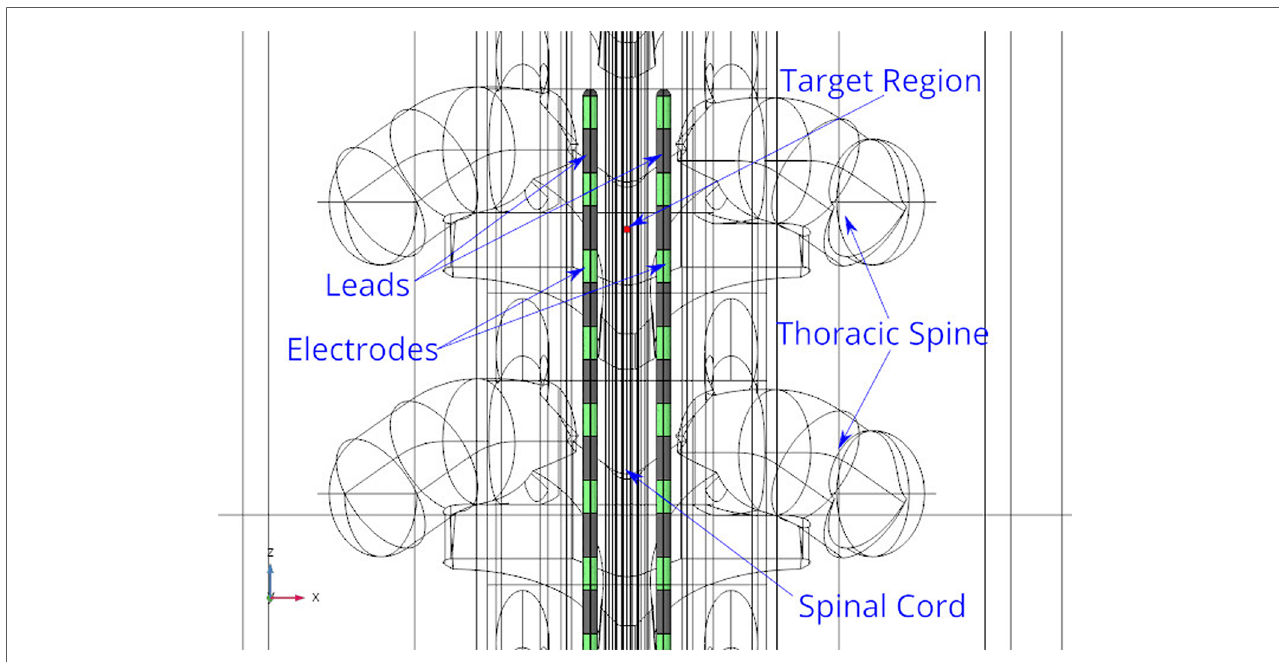
FIGURE 6 Stimulation leads and target region. The leads are shown in grey color and the electrodes are shown in green color. The target region shown in red color, is placed within the white and grey matter